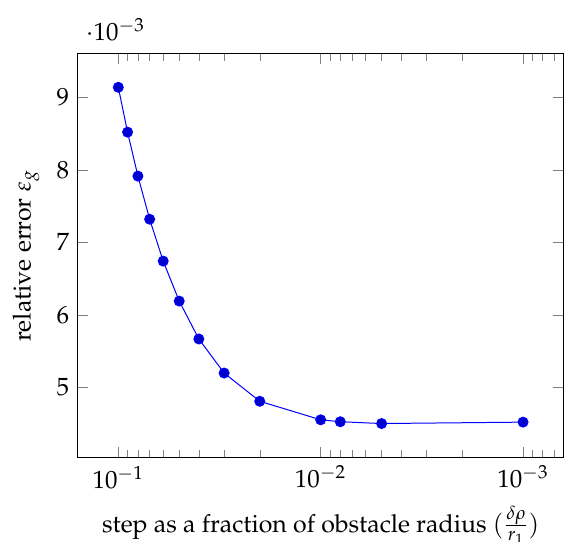
Figure 9. Relative error of the variation of the Green’s function deduced from the Hadamard variation for a perturbation of the radius of the inner disc (displacement component (cid:126) δ c is null). The x -axis is the logarithm of the inverse of the step by which the inner disc is